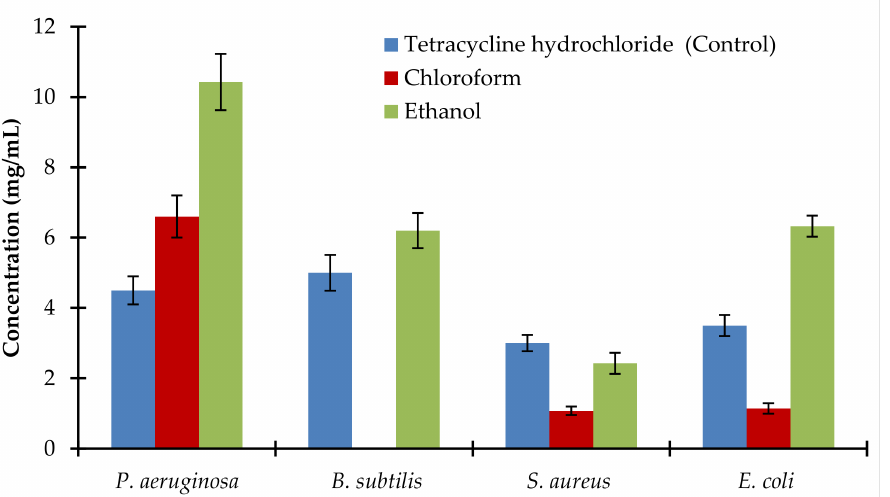
Figure 1. Minimal inhibitory concentration (MIC) values for ethanol and chloroform Avicennia marina roots extract against P. aeruginosa, B. subtilis, S. aureus, and E. coli . Tetracycline hydrochloride was a positive control. Aqueous, petroleum ether, and ethyl acetate extracts did not affect any of the tested bacterial strains. Chloroform extract did not affect B. subtilis . Values are the mean of five replicates ( n = 5). Vertical bars show standard